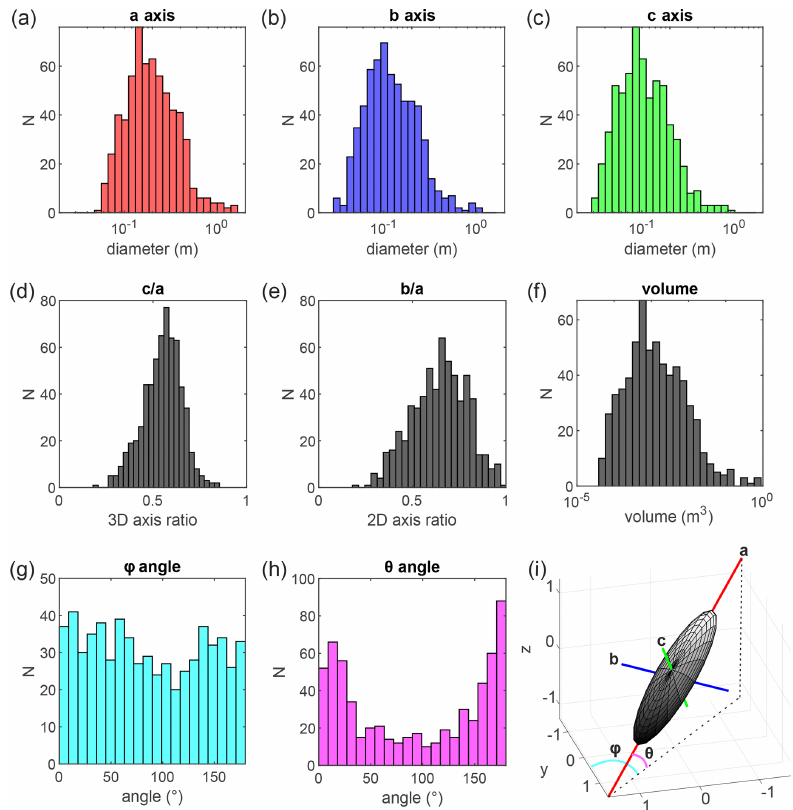
Figure 3. Size, shape and orientation distribution of 630 ellipsoids correctly fitted to the labeled grains. Histogram distribution of the diameters of the ellipsoids along their (a) major a , (b) intermediate b and (c) short c axis. Histogram distribution of the (d) 3D axis ratio ( c/a ), (e) 2D axis ratio ( b/a ) and (f) volume of the ellipsoids. Histogram distribution of the (g) azimuth ϕ and (h) dip θ angle. (i) Three- dimensional view of an arbitrary ellipsoid and representation of the different metrics used to characterize ellipsoid size, shape and